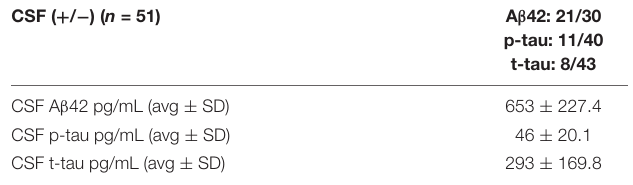
Frontiers in Aging Neuroscience |